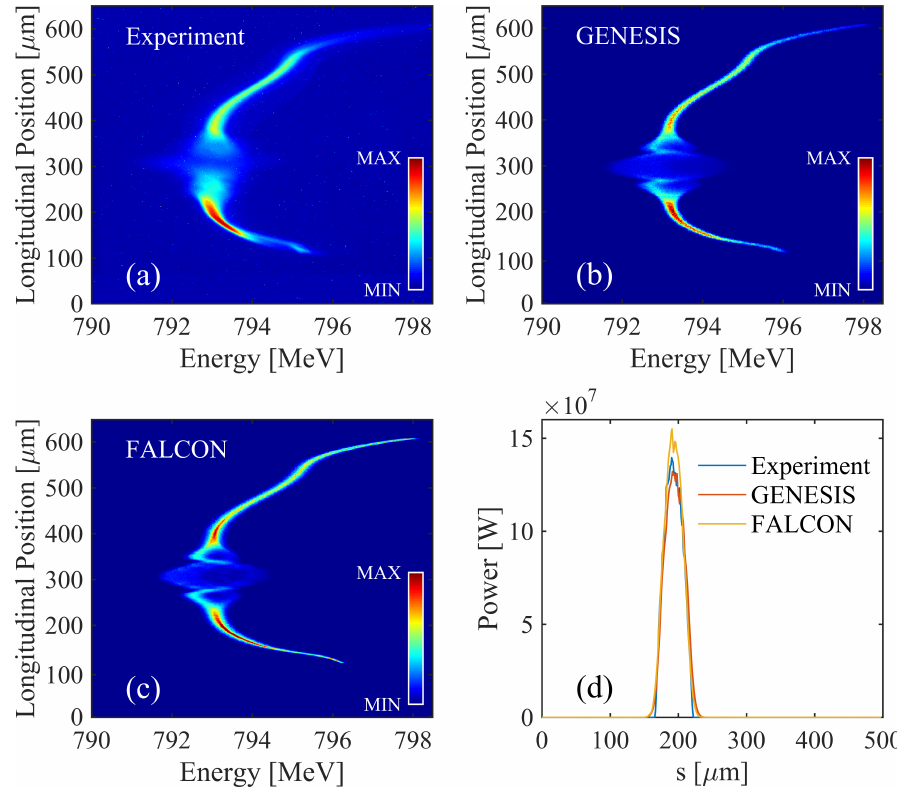
Figure 6. The result of on-line analysis. ( a – c ) The longitudinal phase spaces after lasing through the experiment, GENESIS simulations and FALCON simulations; ( d ) The power profiles of FEL pulses for the experimental measurement and FALCON